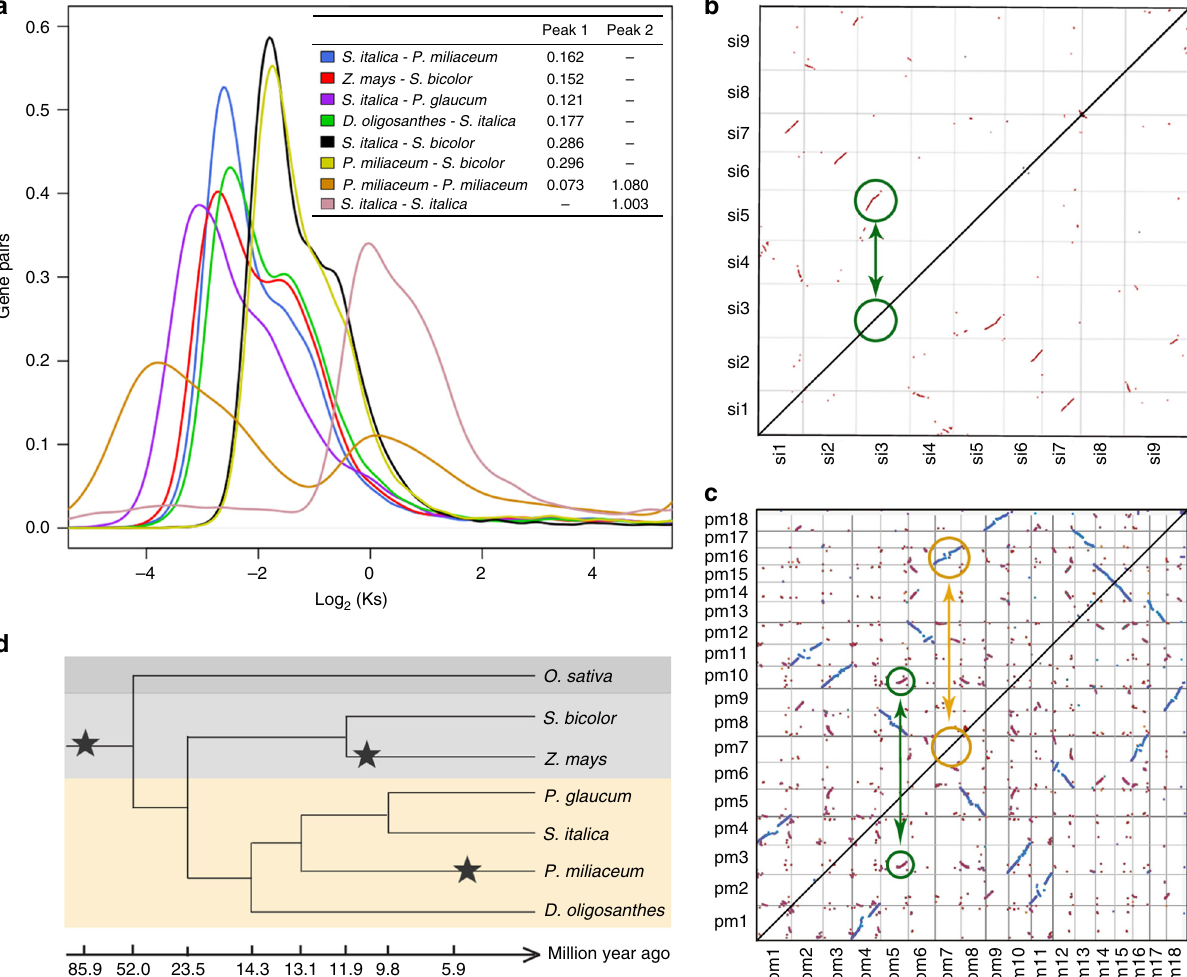
Fig. 4 The phylogeny of Paniceae. a Ks distribution of orthologous and paralogous genes in Paniceae. We further con fi rmed two WGD events in foxtail millet ( b ) and broomcorn millet ( c ), with the paralogous genes in green circles referred to the WGD shared by all grass, and the paralogous genes in orange circles referred to lineage-speci fi c tetraploidization in broomcorn millet. d The phylogeny of Paniceae inferred from Ks distributions. The timeline was calculated based on the divergence between sorghum and maize ( Ks ~ 0.152, 11.9 Mya). The WGD events were marked by stars. Source Data of Fig. 4a